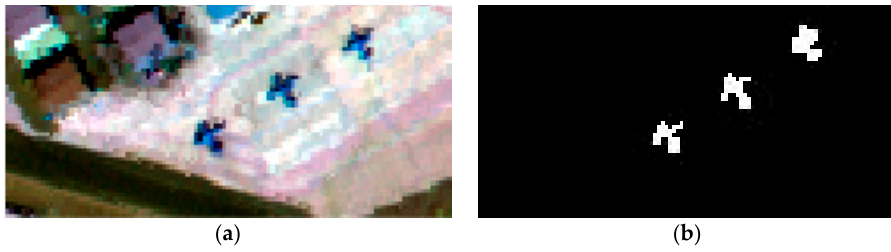
Figure 10. The image of AVIRIS: ( a ) pseudo color display of AVIRIS Dataset 2; and ( b ) reference data.